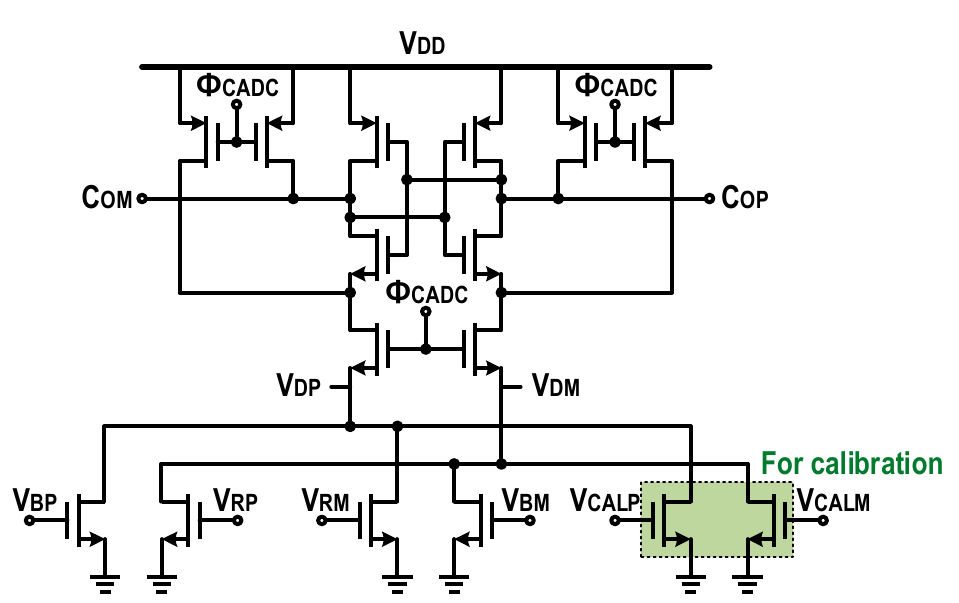
Figure 5. Pseudo differential comparator with the offset calibration capability used in the CADC.